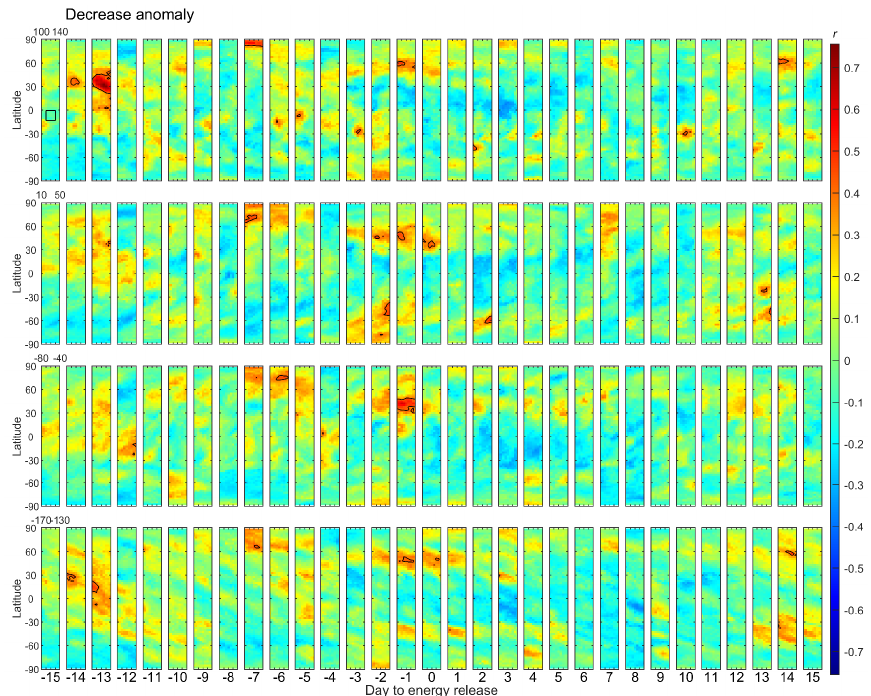
Figure 6. Same as Figure 5 for daily seismic wave energy release ≥ M 5.5 with outliers within Region A and for the TEC decrease anomalies. The contour denotes r α = 0.01 according to the sample size at each D.